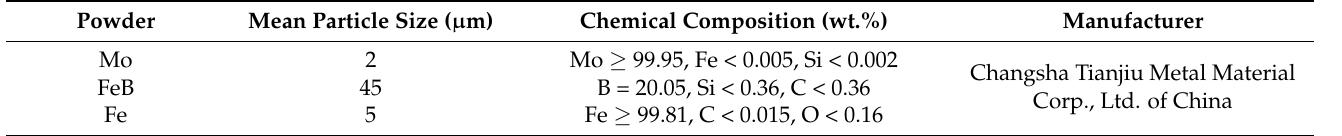
Table 2. Compositions of Mo 2 FeB 2 -based cermets with different Mo content (wt.%).